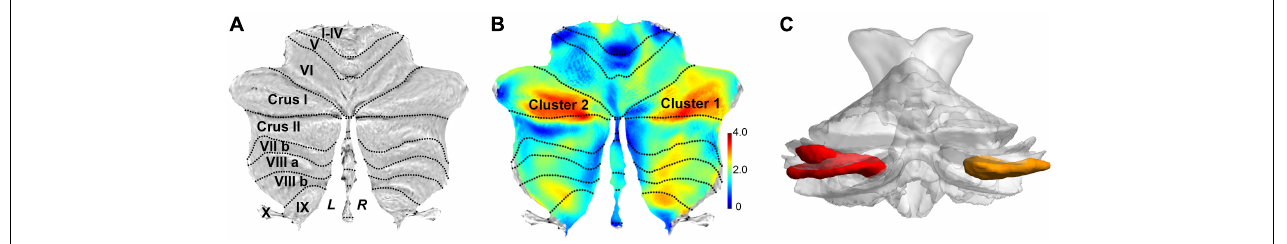
FIGURE 2 | Flat map representation of human cerebellar anatomy and the surviving clusters from spatially unbiased infratentorial (SUIT)–VBM. (A) Flat map showed the surface projection of cerebellar anatomy through the SUIT atlas. The posterior cerebellum lobe is anatomically composed of lobules VI, crus I, crus II, VIIb, VIII, and IX. (B) Statistical differences in cerebellar GMV between the patients with SSD and HC (SSD > HC) are displayed as cerebellar flat map; significant change in GMV in patients with SSD is displayed in orange. (C) 3D presentation of the significance areas: these clusters were used as the ROIs for the FC analysis.